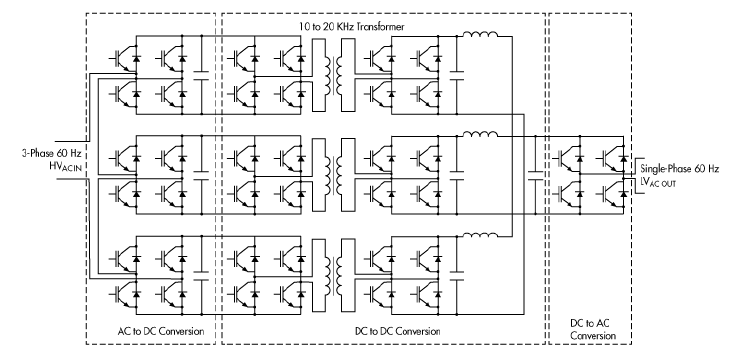
Figure 12. A conceptual design of a solid state transformer